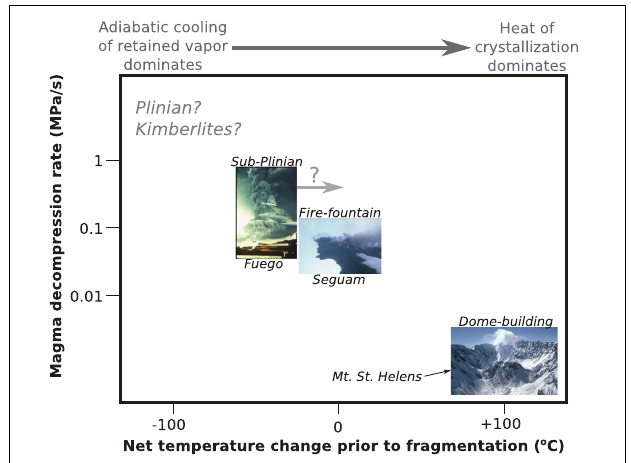
FIGURE 11 | Hypothesized trend between magma decompression rate and temperature change during ascent. We find evidence that the Seguam 1977 magma experienced a net temperature change of ∼ 0 ◦ C during syneruptive ascent and the Fuego 1974 magma experienced a net temperature change between ∼ –40 ◦ C (if our best-fit thermal histories reflect cooling in the conduit) and ∼ 0 ◦ C (if our best-fit thermal histories reflect cooling in the volcanic plume). Blundy et al. (2006) report a temperature increase of ∼ 100 ◦ C accompanying slow extrusion of magma during dome-building eruptions at Mount Saint Helens and Shiveluch volcanoes. Together, these results are suggestive of a negative correlation between decompression rate and temperature change during ascent, which likely relates to higher degrees of melt-vapor segregation and more crystallization in slower ascending magmas. Studies of ascent and syneruptive temperature changes at volcanoes with a wider variety of eruptive styles (e.g., Plinian eruptions) and magma compositions will be required to test the validity of this hypothesized trend. Photo credit: